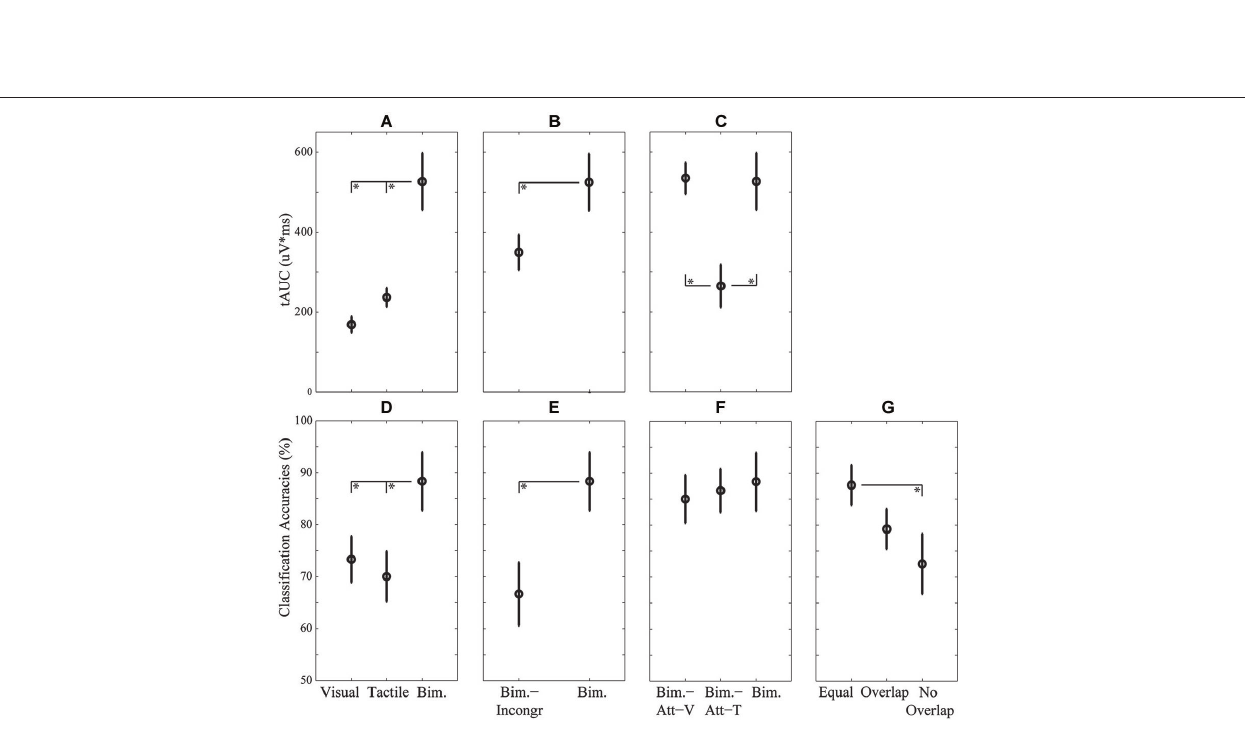
FIGURE 4 | Offline and online classification accuracies. (A) Offline and (B) online classification accuracies after each repetition for the conditions involved in the analysis of the first research question (the effect of Bimodality). (C) Offline and (D) online classification accuracies after each